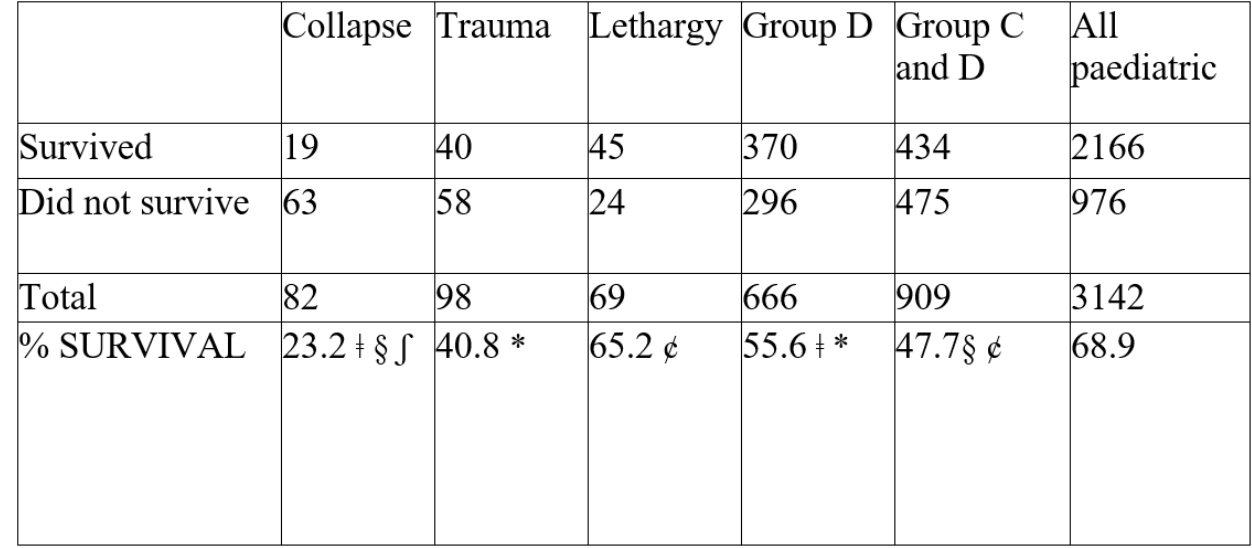
Table 5: Outcome recorded for the three most common presentations for the feline patients 3-6 months old who attended the clinic and followed veterinary advice. Categories indicated by matching symbols ( * ǂ § ʃ ¢) indicate pairs where survival was significantly